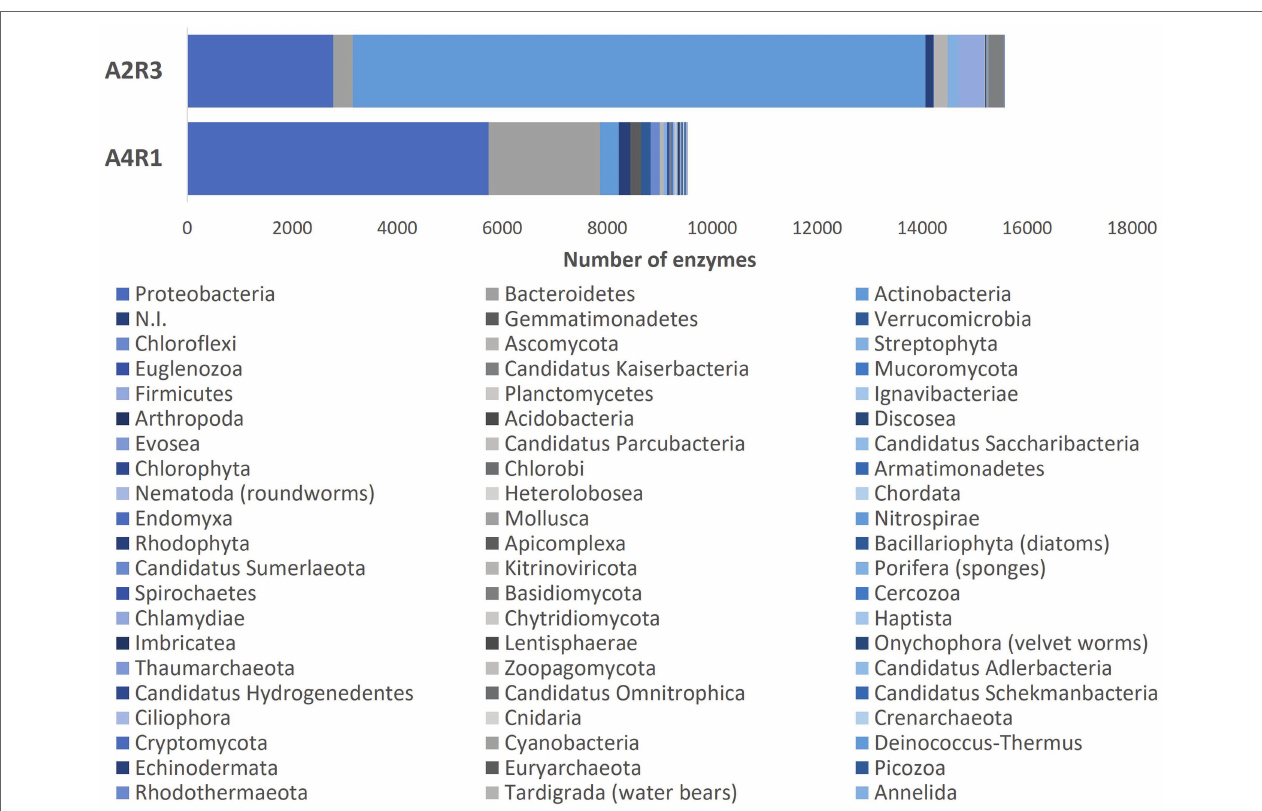
FIGURE 3 | The bars represent the number of differentially expressed transcripts recognized as enzymes identified in the two treatments A4R1 and A2R3, subdivided according to their